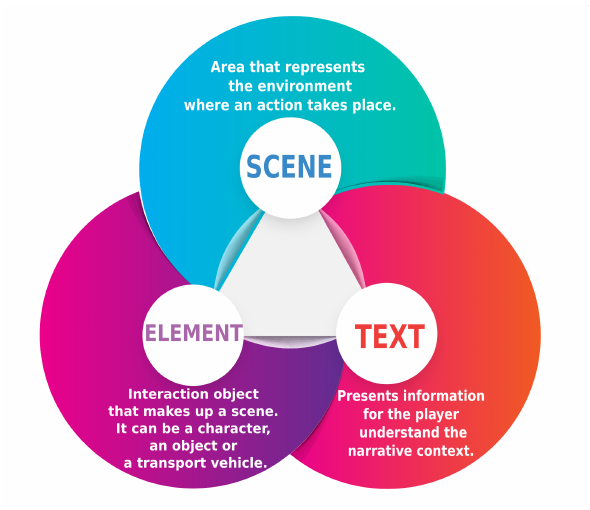
Figure 5 - Pillars of building games in Super Python